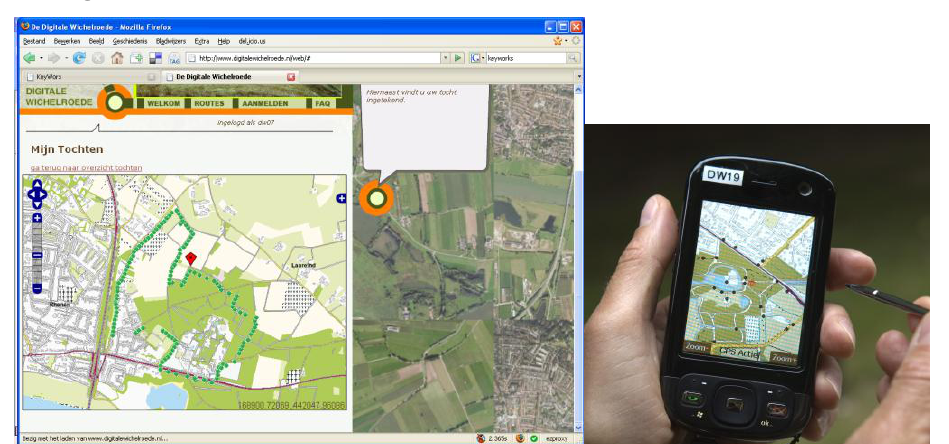
Figure 1. Web browser interface and mobile client interface of